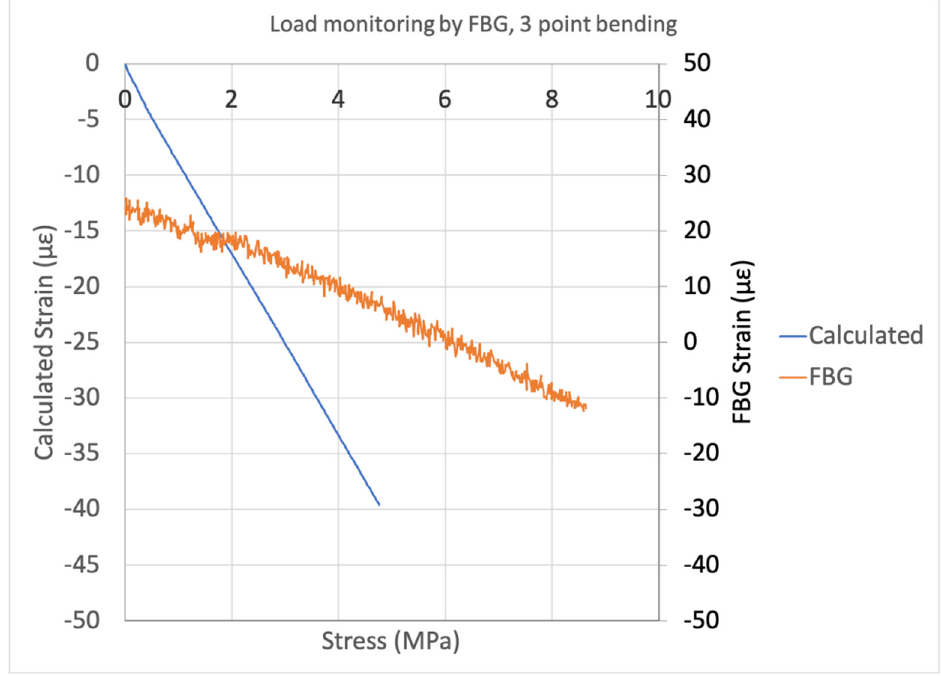
Figure 14. Comparison between FBG and ASTM calculated strains for the 1 min load